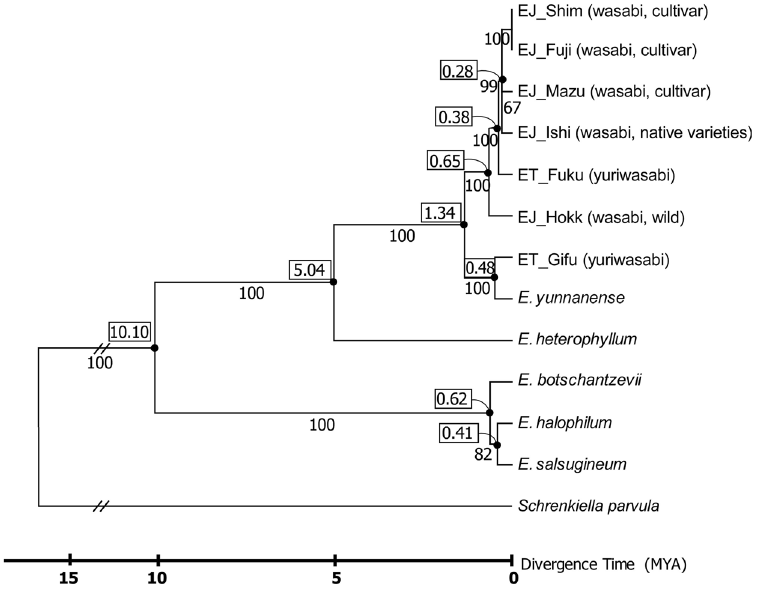
Figure 2. Phylogenetic tree based on 7 Eutrema and one outgroup species. The tree is based on 79 chloroplast protein coding genes (PCGs) using maximum likelihood (ML). The ML tree has a ML value of – lnL = 123620.58. Numbers above nodes are bootstrap support values ≥ 50%. Species and accession names are listed in Table 3. The numbers in boxes represent Mya, millions of years